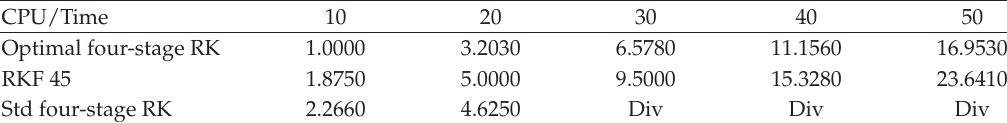
Table 6: Comparison of CPU time among the optimal four-stage RK, RKF 45, and standard four-stage RK with Δ t (cid:6) 0 .